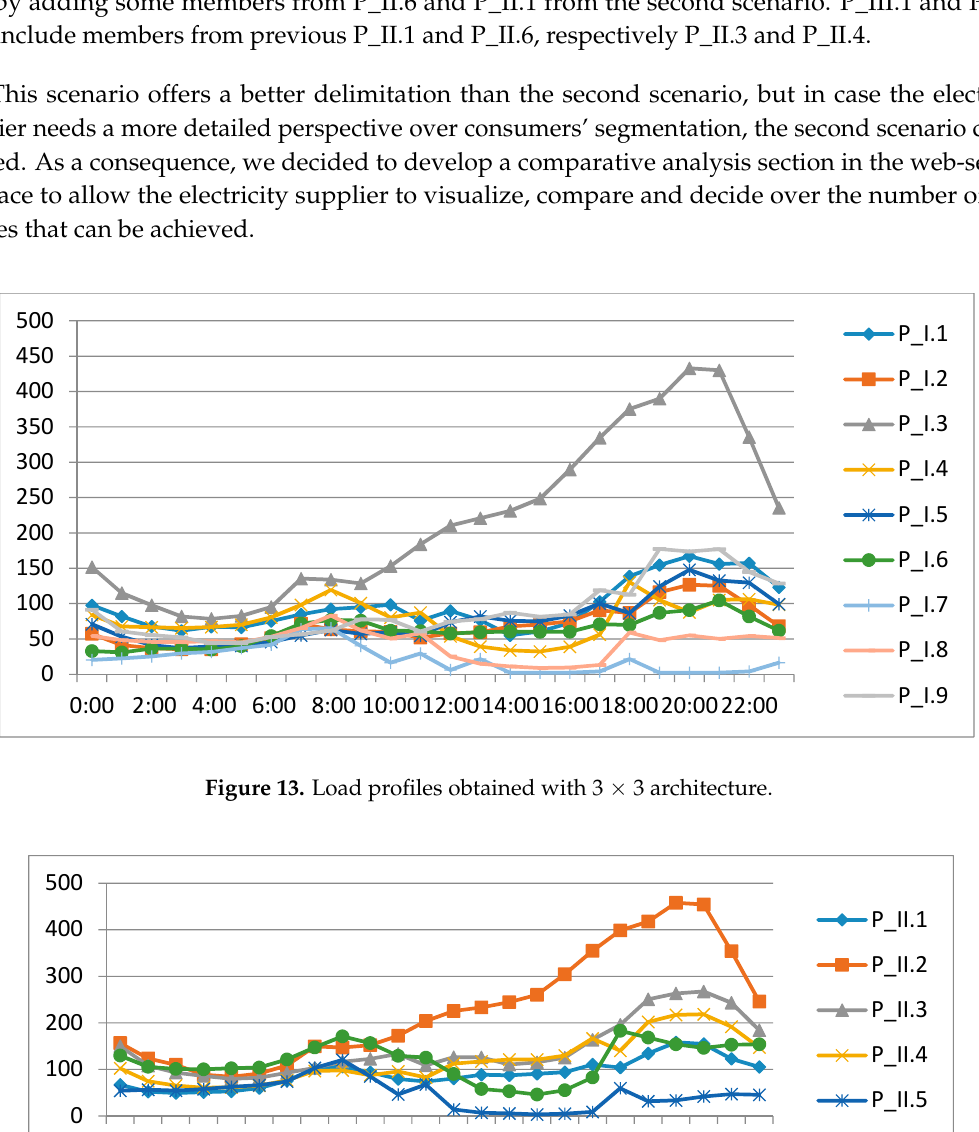
Figure 14. Load profiles obtained with 2 × 3 architecture.